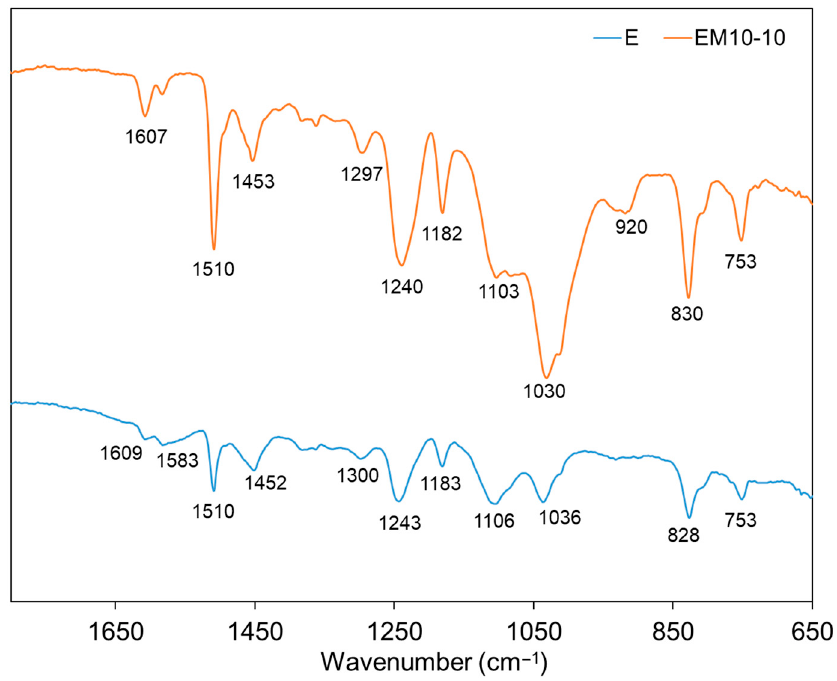
Figure 6. FTIR of the EM10-10 sample and of the neat epoxy resin (E).